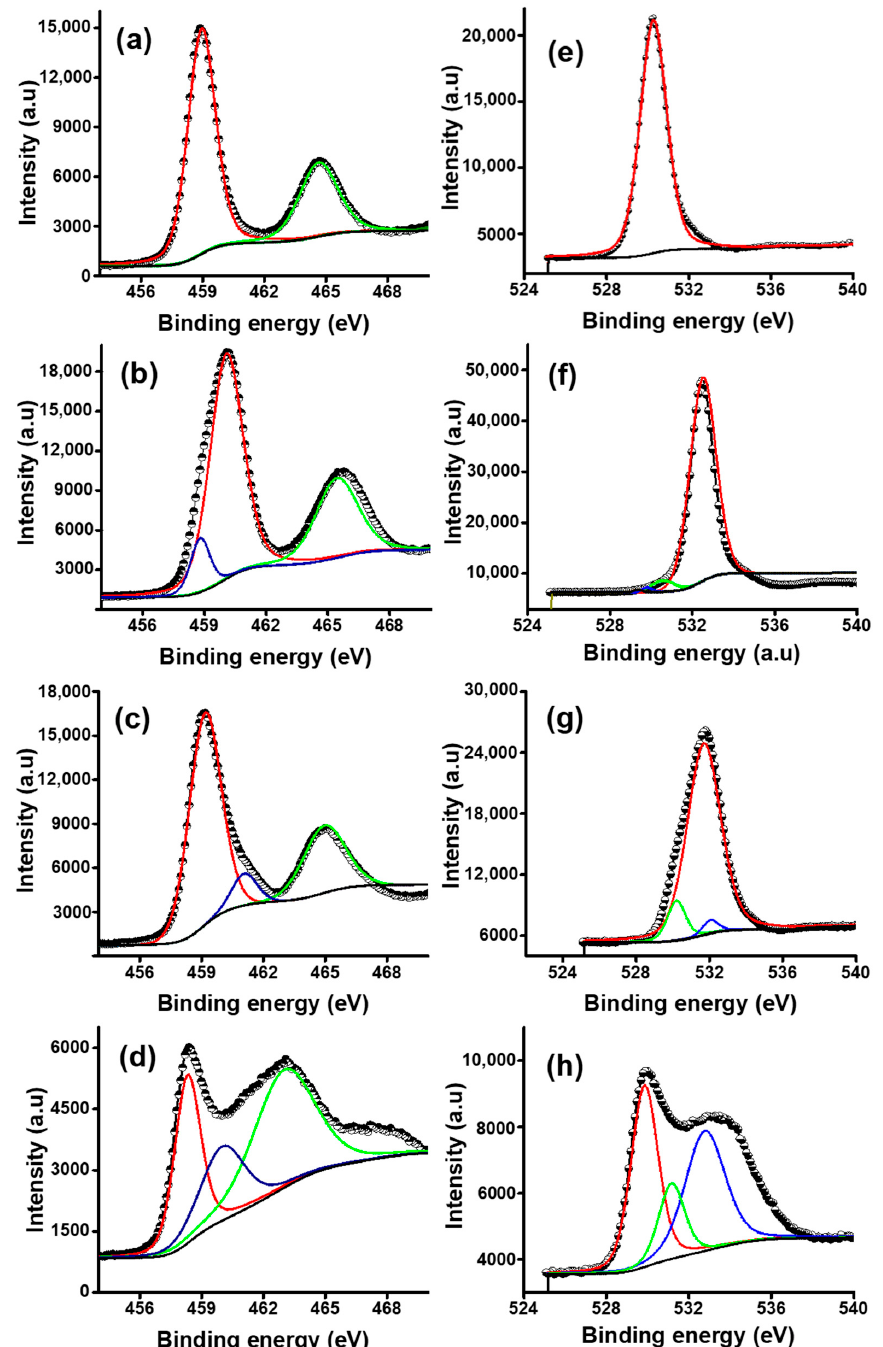
Figure 6. High resolution XPS spectra of Ti 2 p ( a – d ) and O1s ( e – h ) of TiO 2 prepared at various glycerol concentration and calcined at 300 °C ( a ) T1 ( b ) T2, ( c ) T3, ( d ) T4, and O1s for ( e ) T1, ( f ) T2, ( g ) T3, and ( h ) T4.